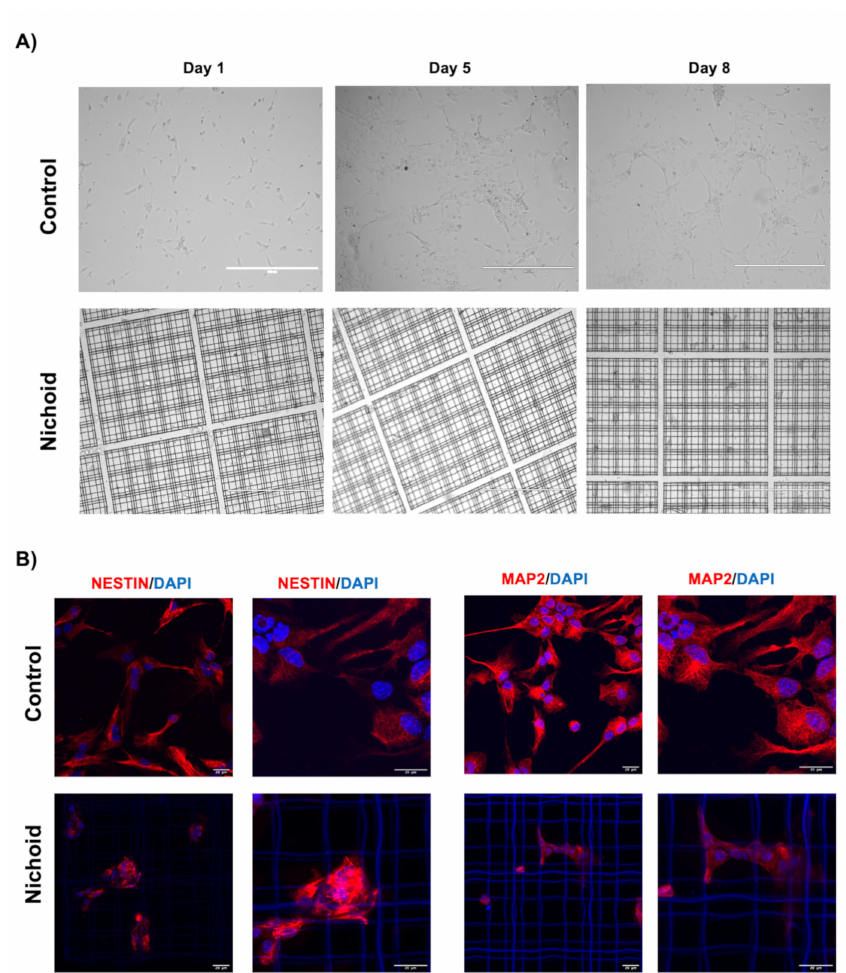
Figure 8. Di ff erentiated neural precursors cells grown inside the Nichoid. ( A ) In vivo direct light images (EVOS FL microscope, EuroClone) of control NPCs (control) or di ff erentiated inside the Nichoid (Nichoid) stimulated with di ff erentiation medium at day 1, 5, and 8. Scale bar: 400 µ m. Images are representative of what was observed in two independent experiments ( B ) Immunofluorescence images of NESTIN and MAP2, in red, and nuclei, in blue (DAPI), of di ff erentiated NPCs in control flat conditions or inside the Nichoid. Scale bar: 20 µ m. Images are representative of three fields acquired per Nichoid ( n =